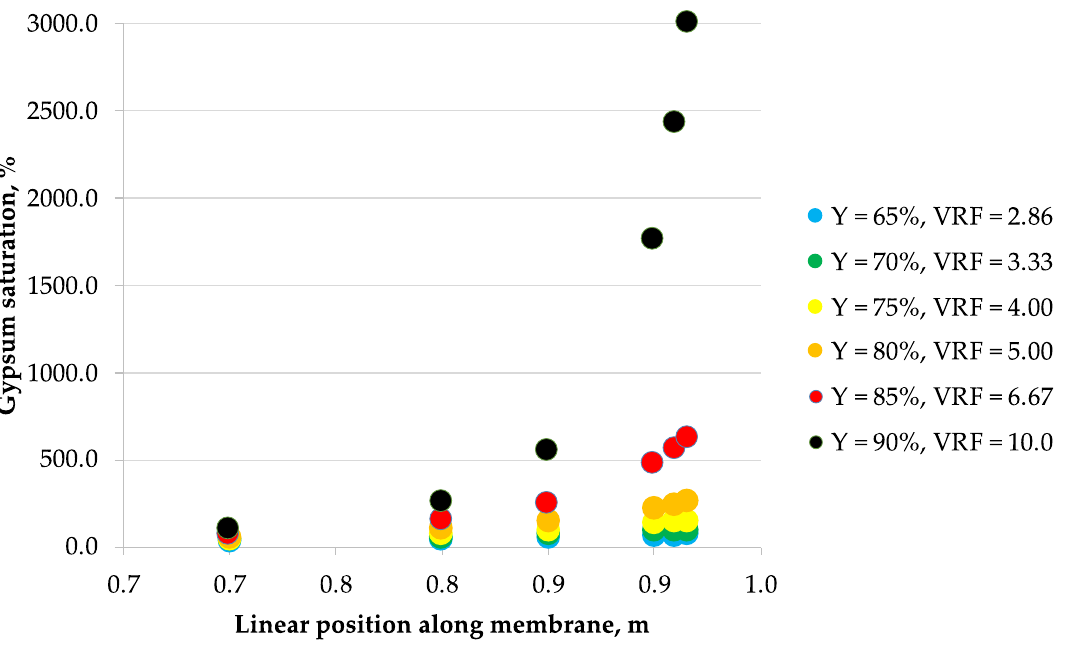
Figure 7. Saturation vs. position along the membrane for mine water B (33.2 g / L as Cl − , 0.937 g / L as SO 42 − , 19.5 g / L as Na + , 0.990 g / L as Mg 2 + , 0.771 g / L as Ca 2 + ) and NFDL nanofiltration membrane.